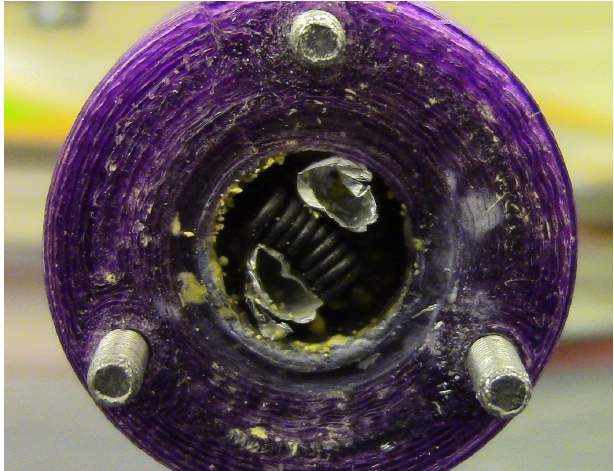
Figure 15. Photograph inside the propellant chamber after test firing showing unreacted CBA